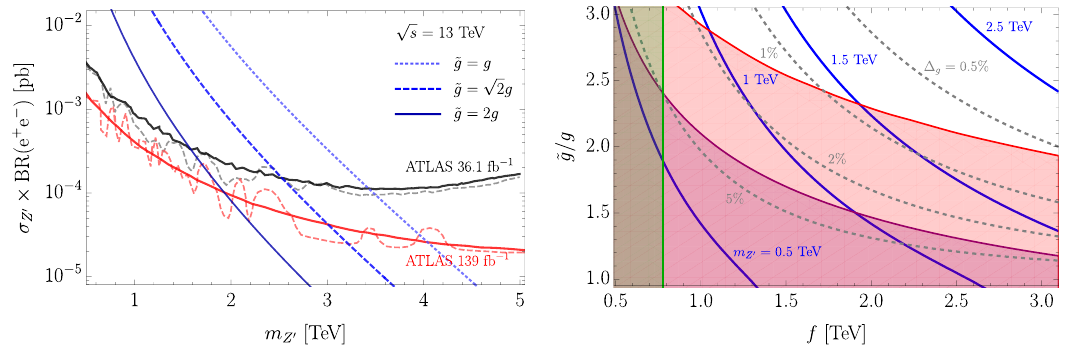
Figure 7 . (Left) Upper 95% CL limits on Z 0 cross section times branching ratio to dileptons as a p function of the Z 0 mass from a published search in 36 : 1 fb (cid:0) 1 of data at s = 13 TeV [52] (expected bound as black solid and observed as dashed) and from a more recent search with 139 fb (cid:0) 1 [53] p (red), as well as the prediction for the twin Z 0 for di(cid:11)erent SU(2) gauge couplings: ~ g = g; 2 g; 2 g e L (blue dotted, dashed, solid respectively). (Right) In the plane of Higgs decay constant f and ~ g=g , excluded regions from Z 0 bounds (red shaded), the Y -parameter (purple shaded) and (cid:24) < 0 : 1 (green shaded). Also shown contours of constant twin Z 0 mass (blue solid) and Higgs tuning (grey dashed), the latter computed with g (cid:26) =